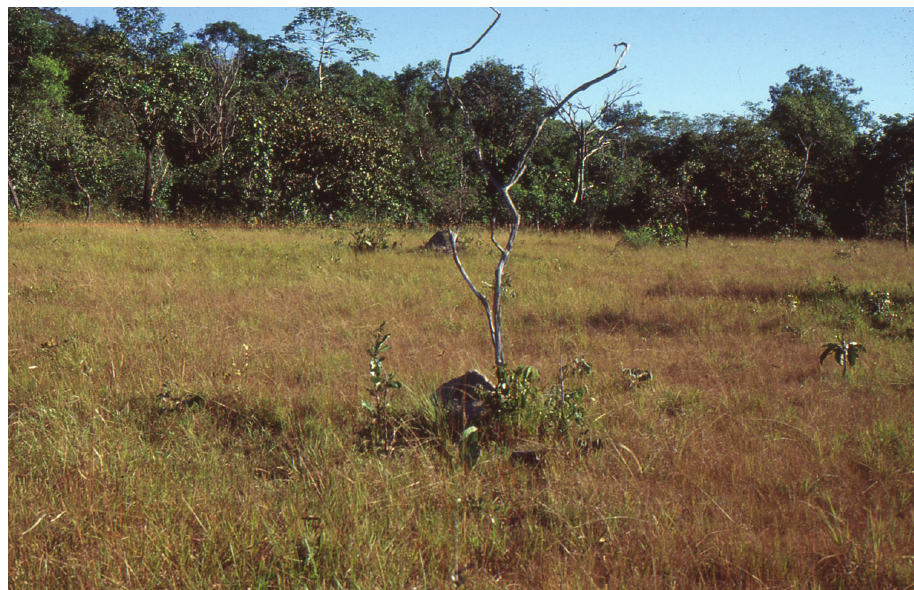
Figure 2. Campos of Pará in southern Amazonia, natural habitat of the new species. Photograph taken by the author in 1979. The region was largely threatened in recent years by anthropic